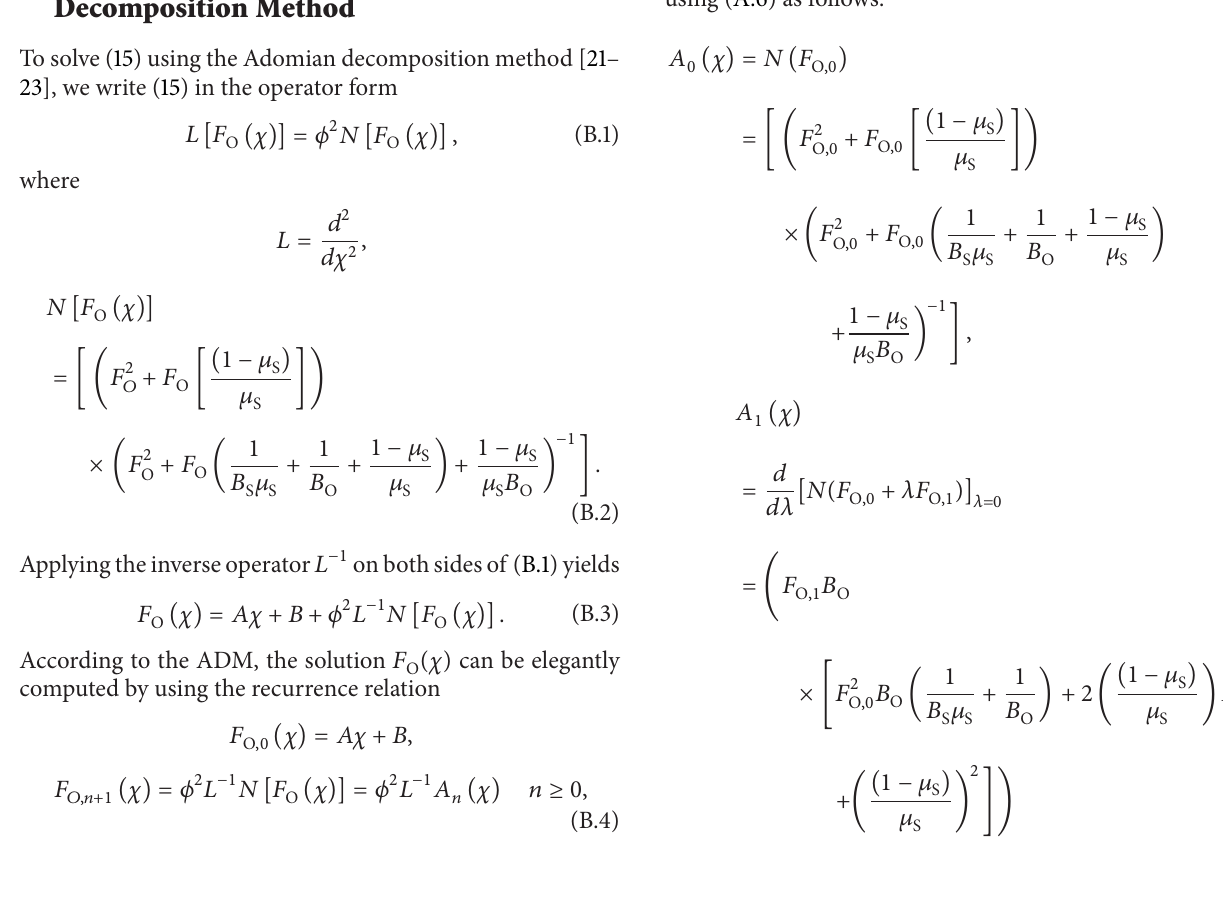
for various values of Thiele modulus 𝜙 2 S = 300 ( 𝑑 = 136.46 𝜇 M) (v) 𝜙 2 O